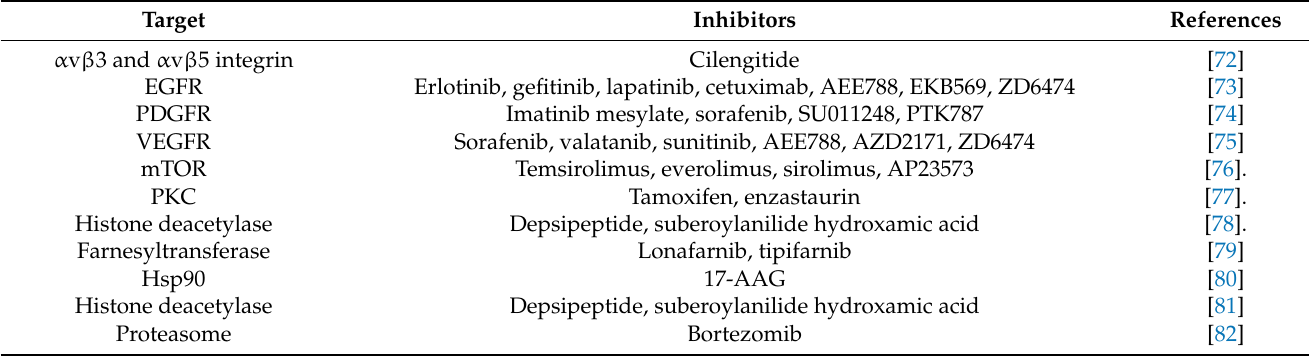
Table 2. Targeted therapies in